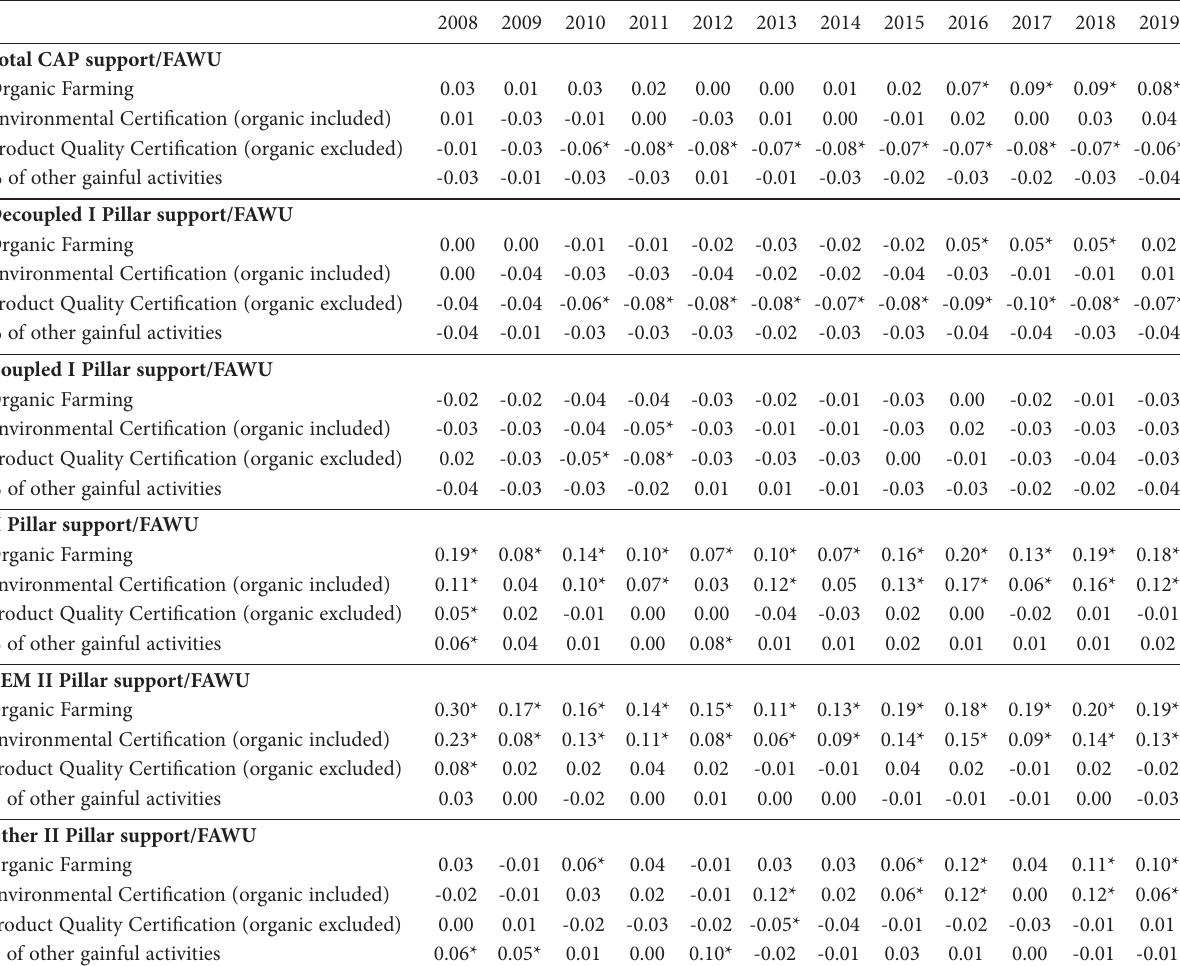
Table 5. Correlation coefficients between CAP support per unit of FAWU and different certifications within the Italian 2008-2019 FADN balanced